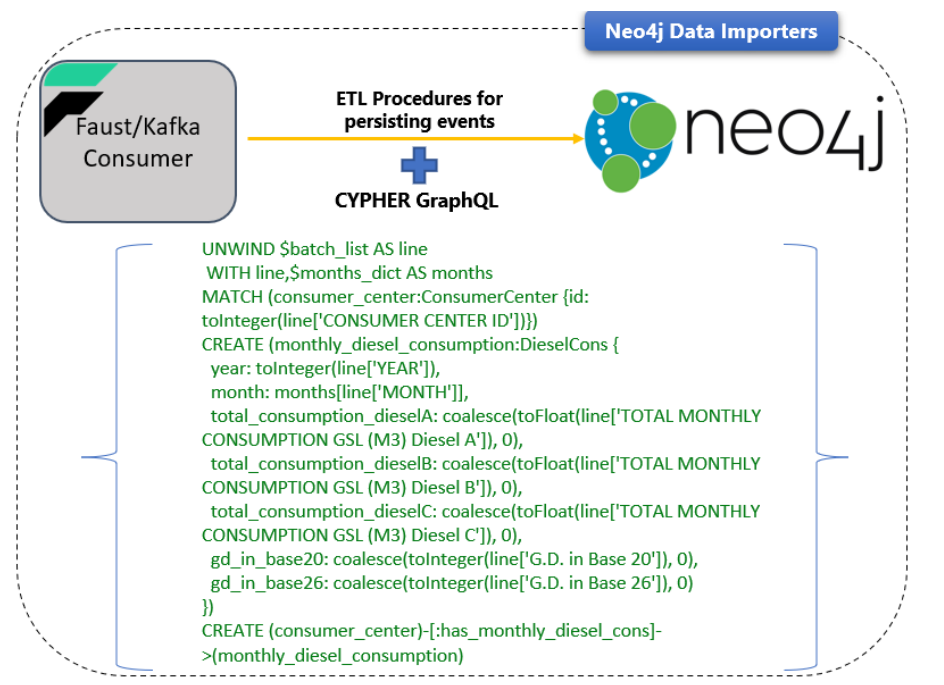
Figure 4. Data flow in the Reasoning Engine Kafka consumer .